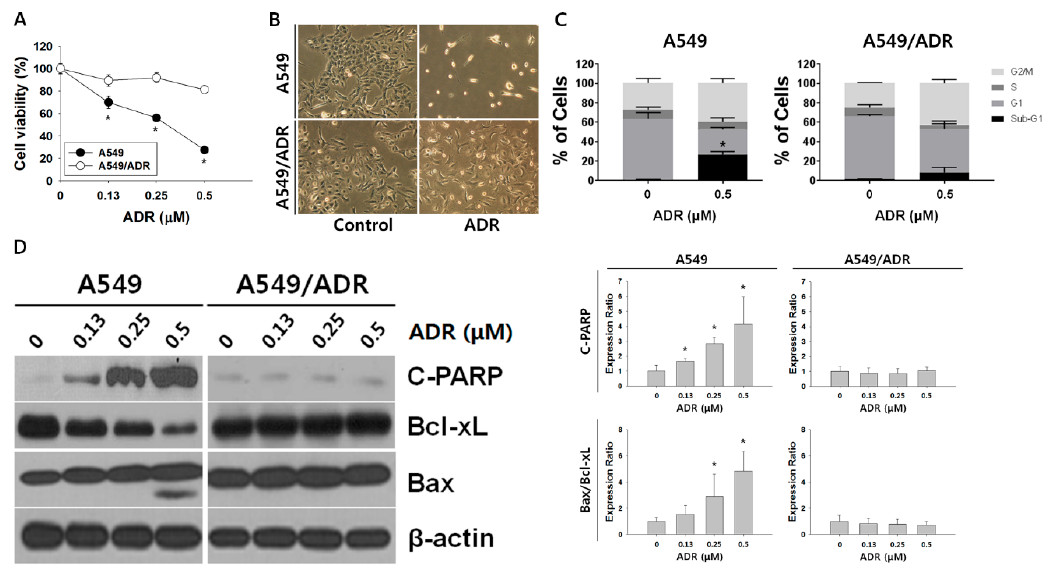
Figure 1. Comparison between A549 cells and ADR-resistant non-small cell lung cancer cells (A549/ADR). ( A ) MTT assay of A549 and A549/ADR cells treated with ADR (0.15–0.5 μ M) for 48 h. ( B ) Morphological features of human lung A549 and A549/ADR cells treated with 0.5 μ M ADR for 48 h. The cells were photographed at 200×. ( C ) A549 and A549/ADR cells were treated with ADR (0.5 μ M) for 48 h and analyzed by flow cytometry after PI staining. The data shown are representative of three independent experiments indicating the quantification of sub-G1, G1, S, and G2/M populations. ( D ) Expression levels of apoptosis-related proteins were analyzed by Western blotting after 48 h of ADR treatment. β -actin was used as an internal control. The Western blotting intensities were quantified using ImageJ software. * p < 0.05. ADR: Adriamycin.